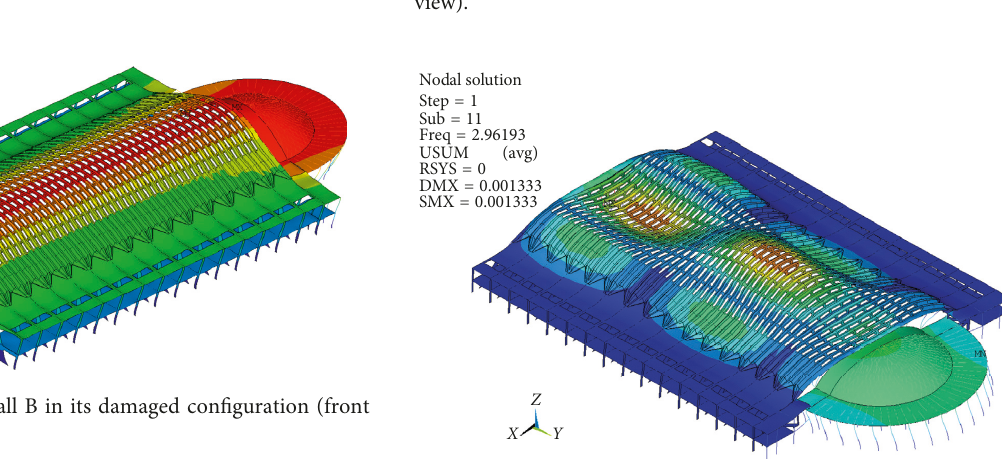
Figure 14: Mode 11 of Hall B in its damaged configuration (apse